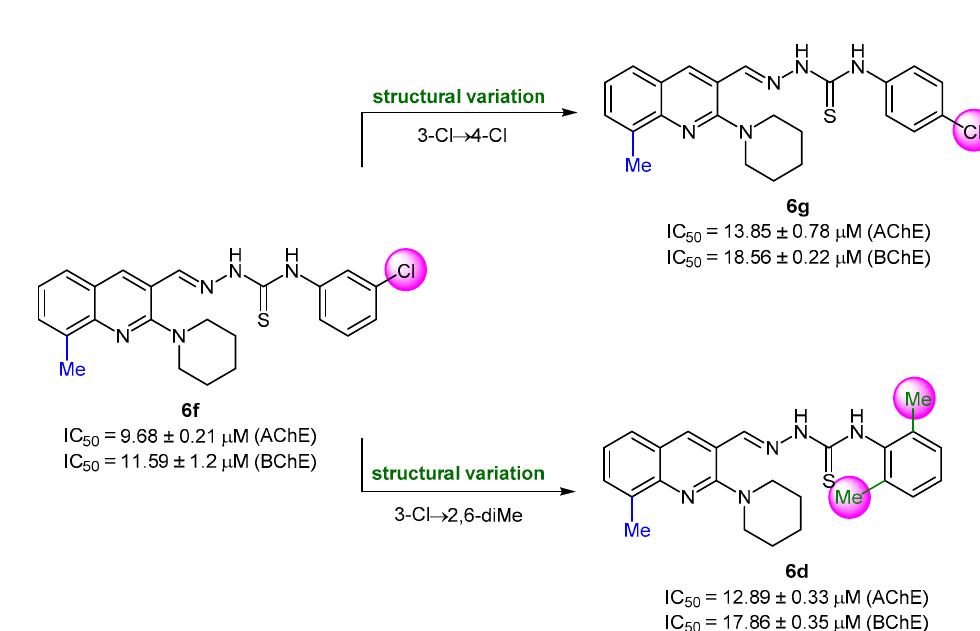
Figure 4. Structure–activity relationship analysis of compounds 5g , 5i , 6g , and 6i .